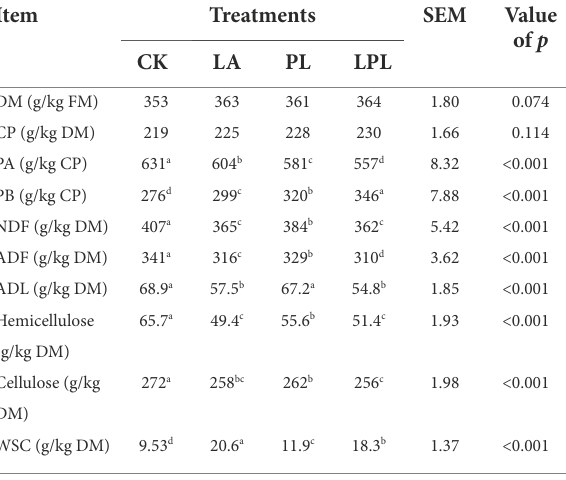
TABLE 3 The nutrient composition of alfalfa silage treated without or with different additives. Item